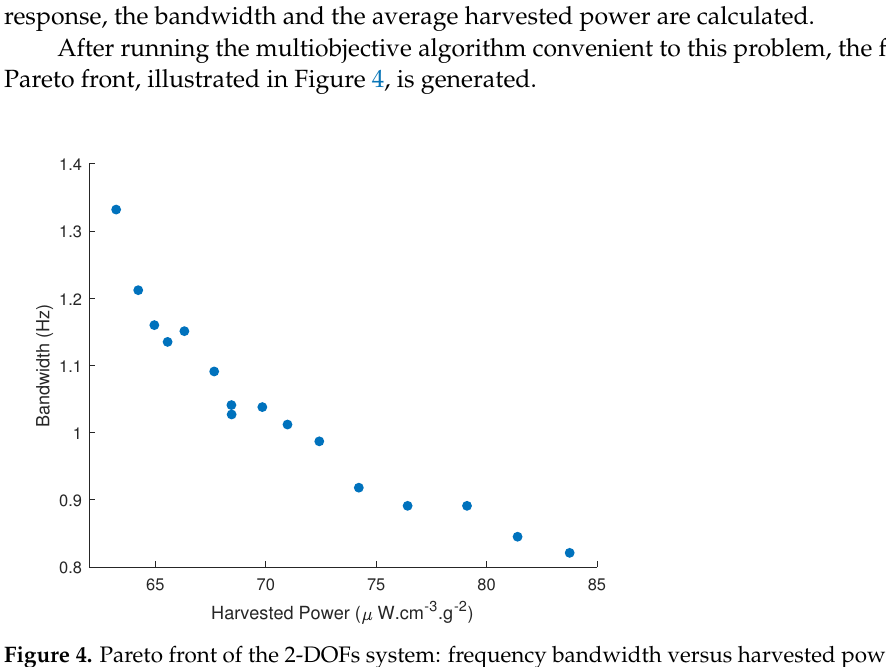
Figure 4. Pareto front of the 2-DOFs system: frequency bandwidth versus harvested power.